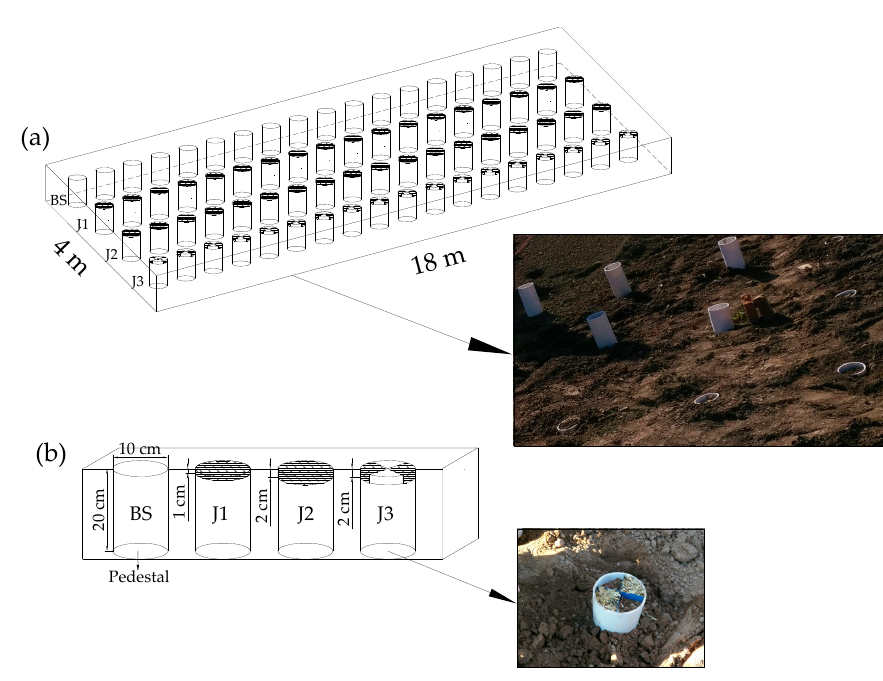
Figure 2. Schematic diagram of experimental design: ( a ) experimental layout; ( b ) surface treatments of micro-lysimeters. BS, bare soil.